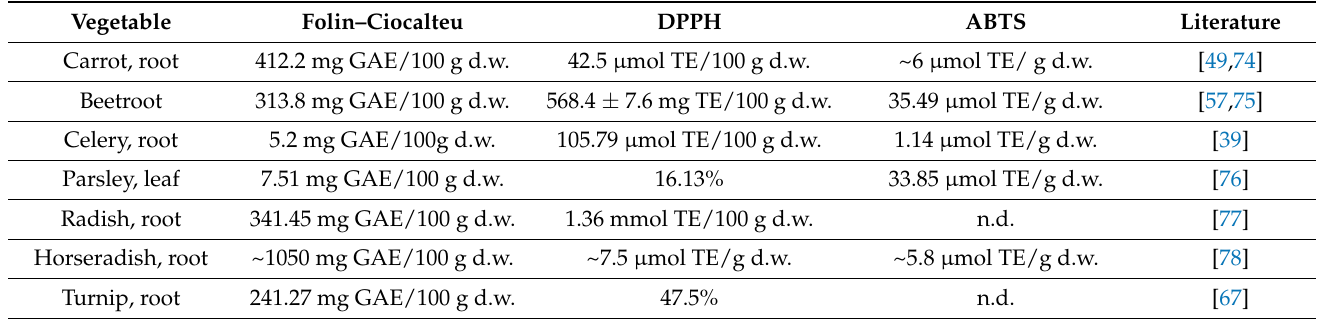
Table 3. Summary of the antioxidant potential of root